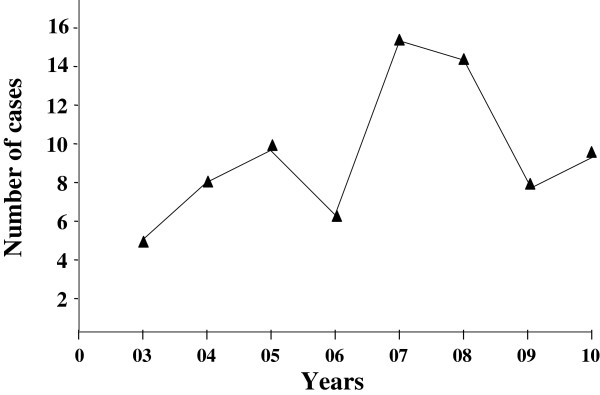
Annual incidence of acute cervical lymphadenitis and infections of the retropharyngeal and parapharyngeal spaces. The incidence was calculated for each year from 2003 (03) to 2010 (10).